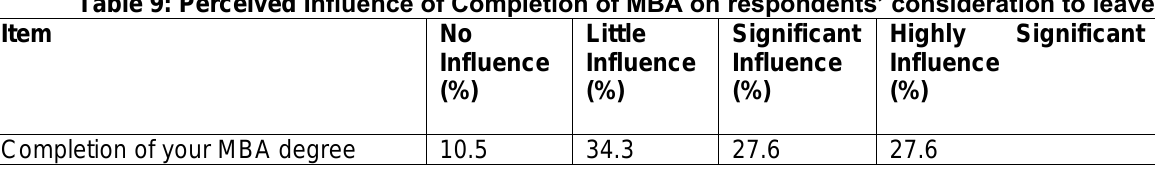
Table 9: Perceived i nfluence of Completion of MBA on respondents’ consideration to leave